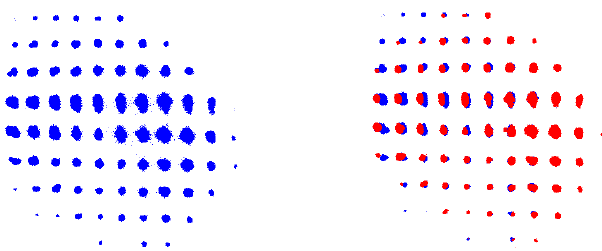
FIG. 7. (Color) Pepper-pot image of the combined bismuth beam with charge states 20 þ and 21 þ (on the left) and super- imposed images of 209 Bi 20 þ (blue) and 209 Bi 21 þ (red) beams transported individually (on the right).